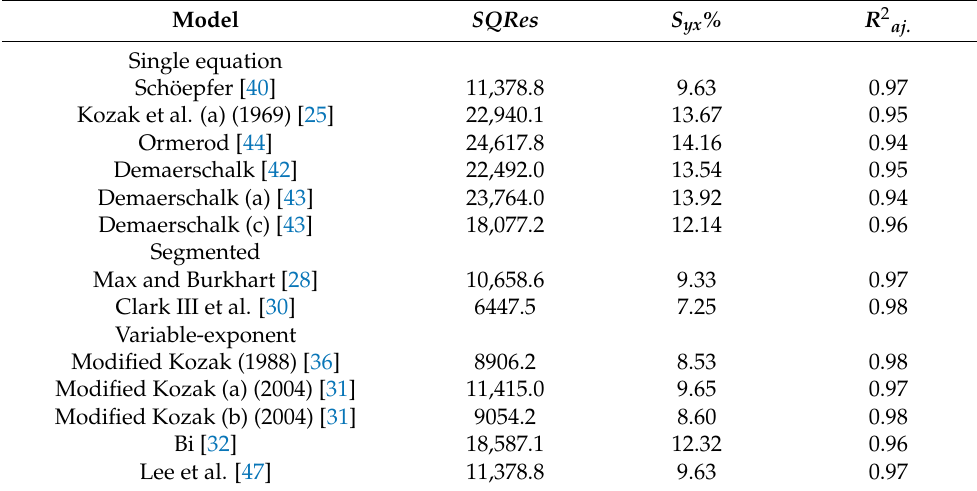
Table 7. Adjustment and precision statistics for the taper models without stratification of the Tectona grandis L. f. data, central-west region, Brazil. Model SQRes S yx % R 2 aj. Single equation Schöepfer [40]